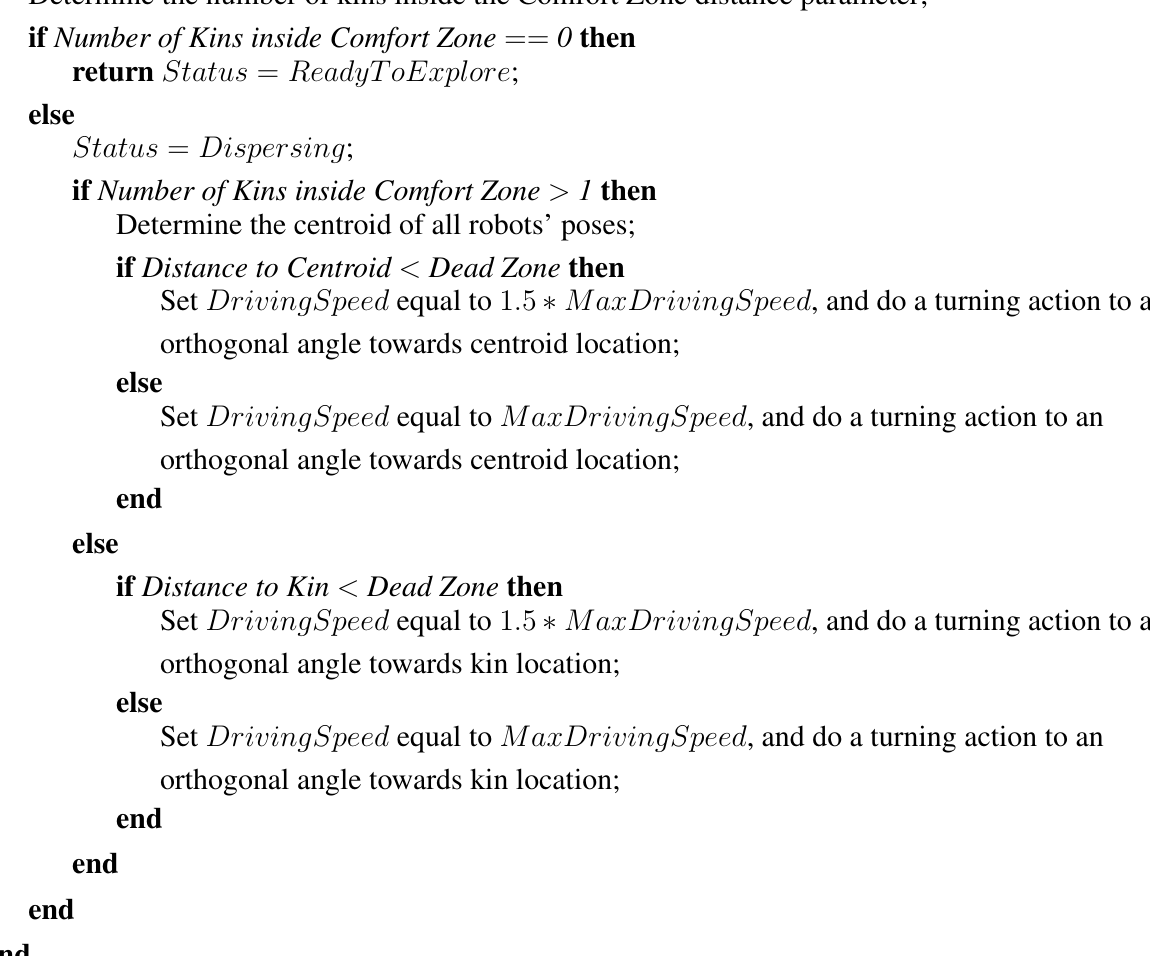
Algorithm 4. Disperse